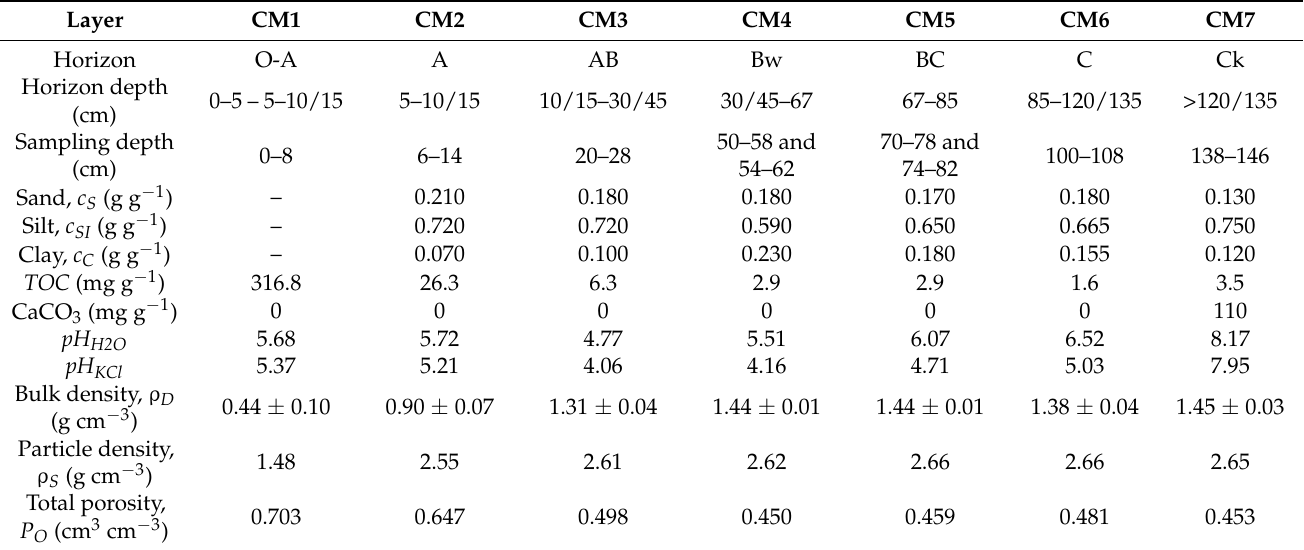
Table 1. Selected physical and chemical properties of the studied